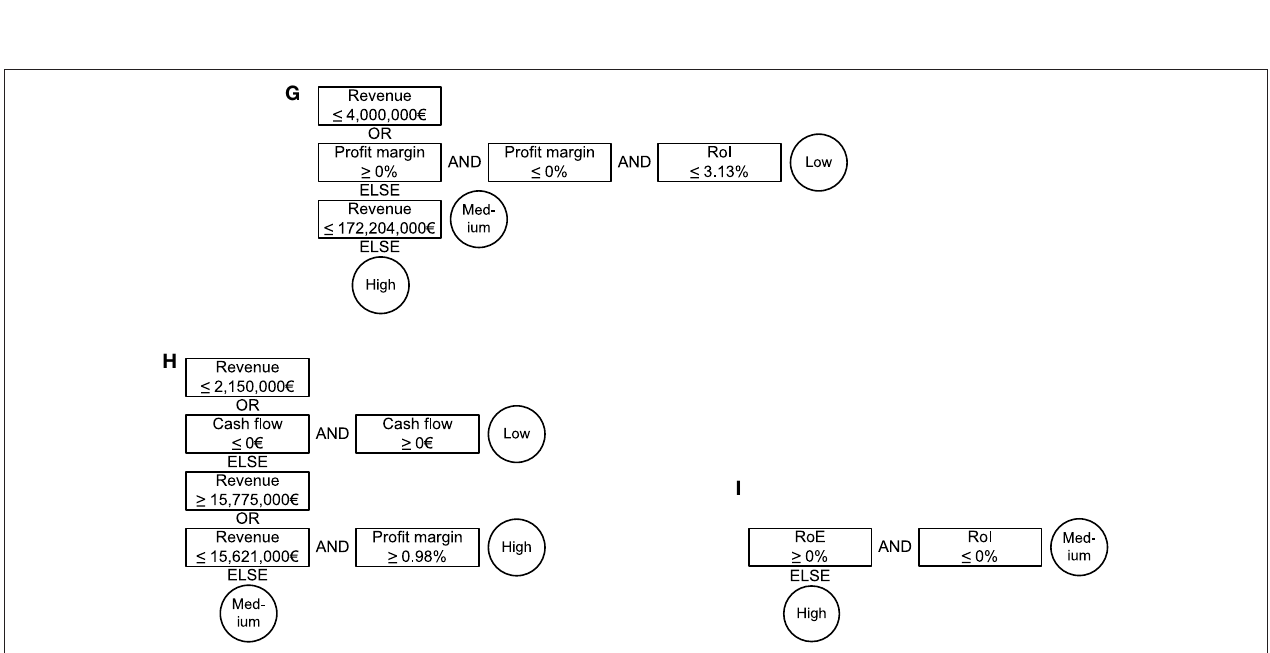
FIGURE 5 | Example models for RIPPER DNFs built on the three data sets. (G) Trade data set model. (H) Construction data set model. (I) Finance data set